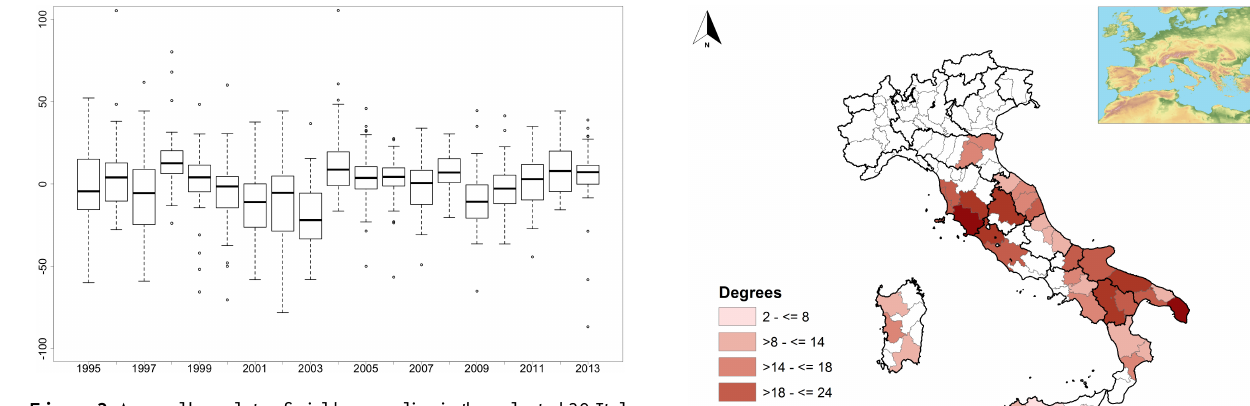
Figure 3. Annual boxplots of yield anomalies in the selected 39 Ital- ian provinces.